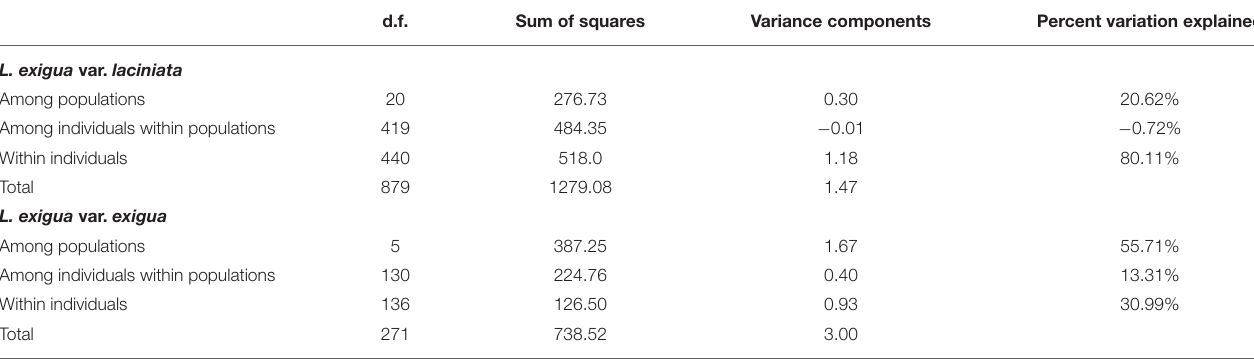
0.12 to 0.81 between populations of L. exigua var. exigua and from 0.50 to 0.89 between populations of L. exigua var. laciniata and L. exigua var. exigua ( Supplementary Table 1 ). Jost’s D, which is scaled according to the diversity present in a population, ranged from 0.00 to 0.08 between populations of L. exigua var. laciniata , from 0.08 to 0.81 between populations of L. exigua var. exigua, and from 0.34 to 0.81 between populations of L. exigua var.